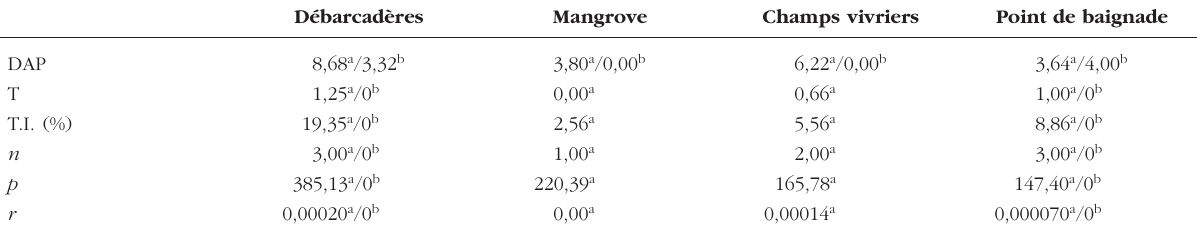
Tableau I. – Paramètres entomologiques de la transmission dans les différents biotopes du foyer de